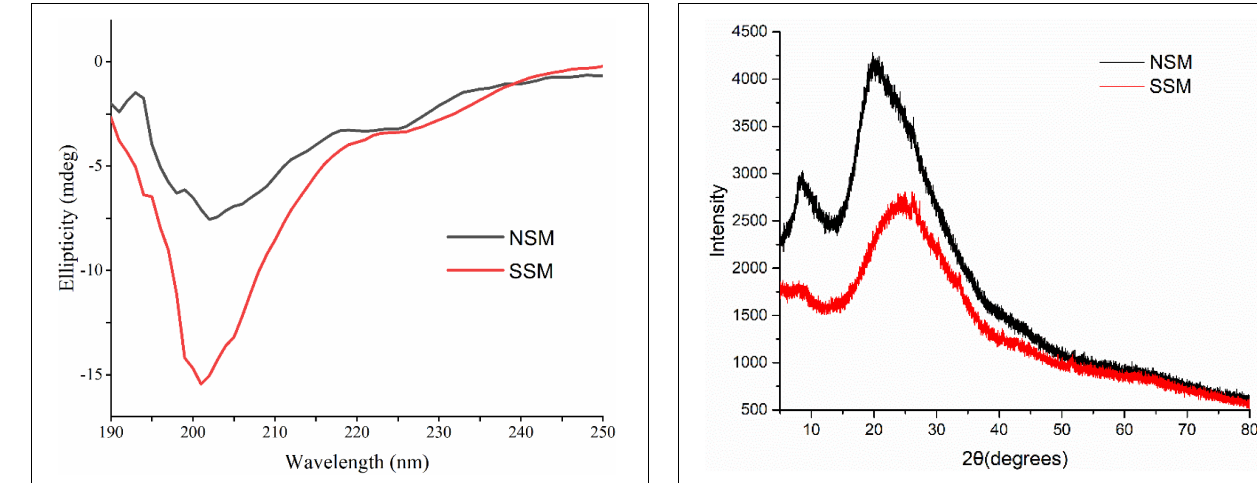
FIGURE 7 | The X-ray diffraction (XRD) patterns of the proteins from native- and steam-exploded soybean meal. NSM, native soybean meal; SSM, steam-exploded soybean